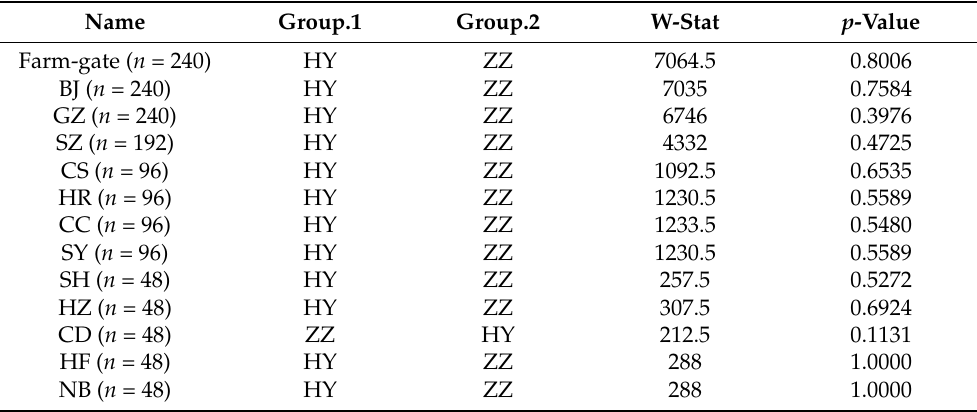
Table 3. The differences between sources in the farm-gate group and the wholesale market